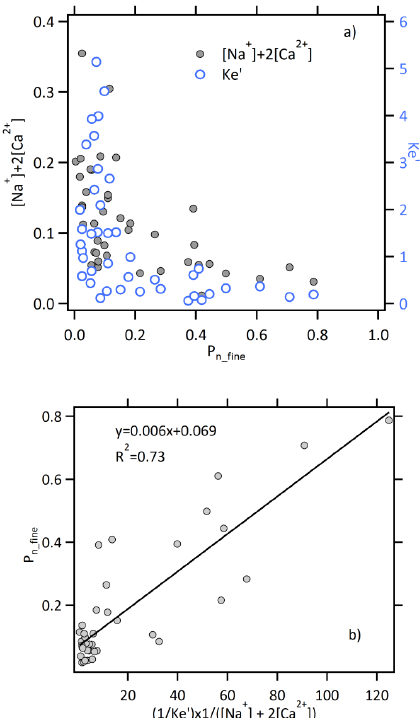
Figure 5. (a) Relationships of aerosol nitrate fraction in the fine mode ( P n_fine ) (<1.8 μm) with modified NH 4 NO 3 dissociation equilibrium constant ( K e ') and equivalent amounts of [Na + ] + 2[Ca 2+ ] in the size range of >3.2µm; (b) Empirical relationship between P n_fine and (1/Ke’)×1/([Na + ]+2[Ca 2+ ])